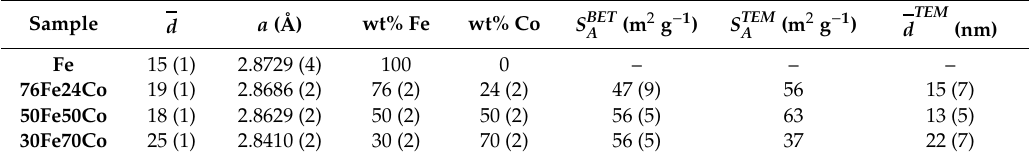
Table 1. Mean crystallite size d and lattice parameter a obtained from XRD analysis of metallic bcc reflections; Fe and Co content from EDX; BET-measured surface area S BET ; surface area S TEM and A A TEM volume-weighted mean diameter d calculated from TEM size distributions. The numbers in parenthesis represent the standard error in units of the last significant